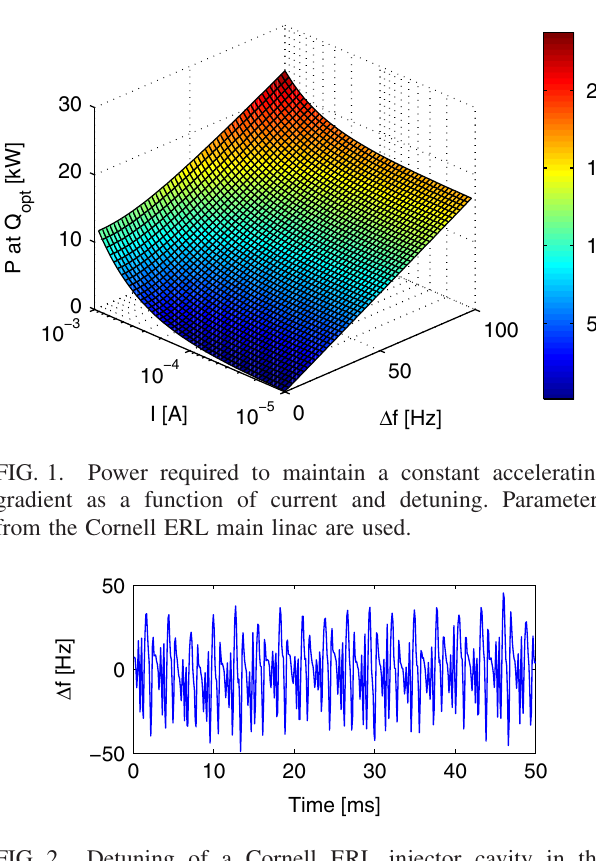
FIG. 2. Detuning of a Cornell ERL injector cavity in the presence of microphonics.